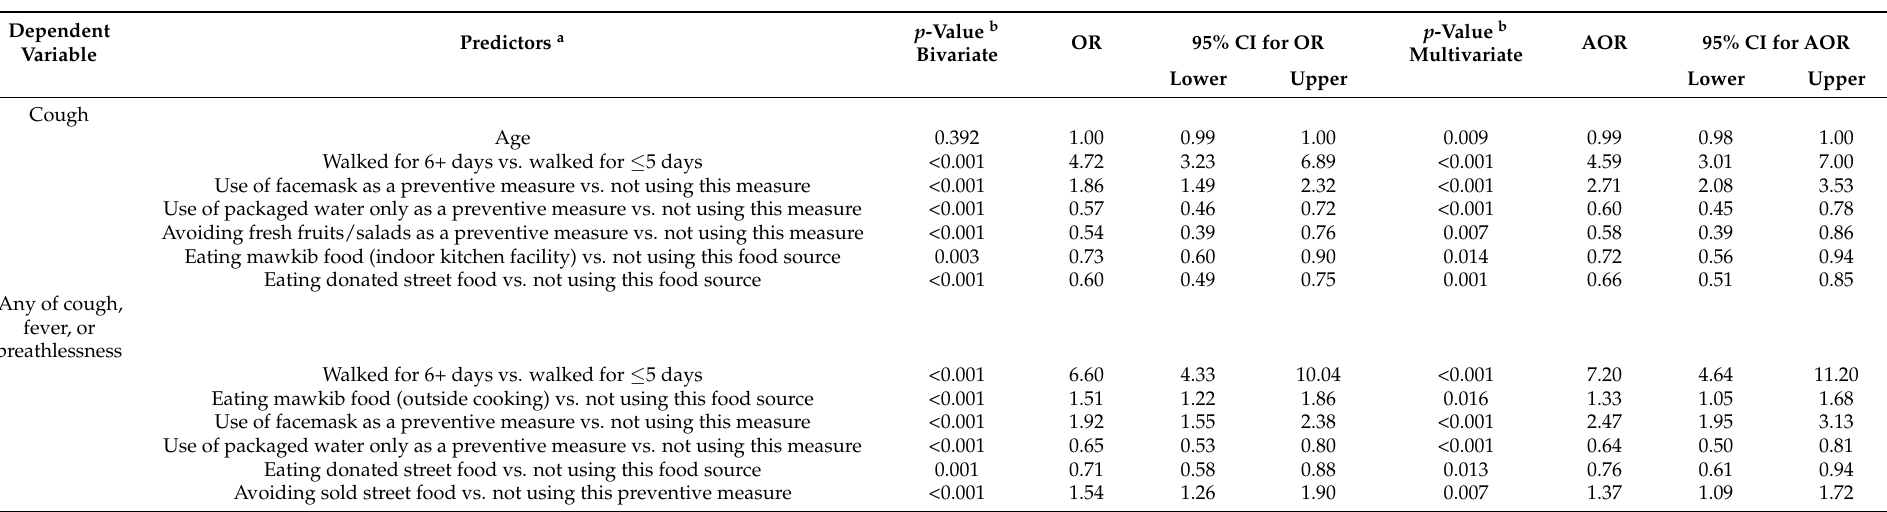
Table 4. Logistic regression analysis of predictors for the development of cough and any of cough, breathlessness, or fever in participants of the 2019 Arbaeen procession. Dependent